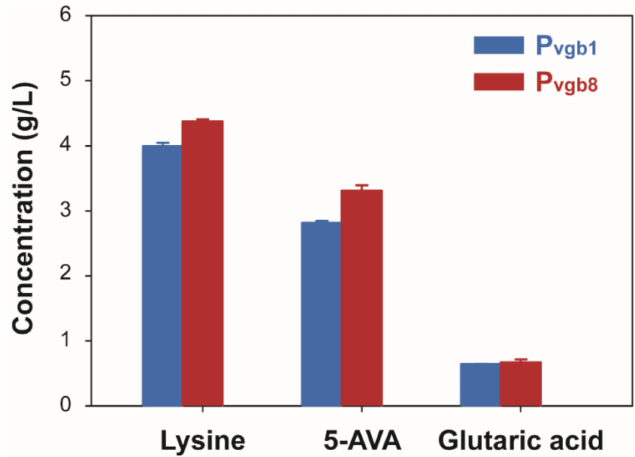
Figure 4. 5-Aminovaleric acid, L-lysine, and glutaric acid production by recombinant C. glutamicum 5AVA1 His and 5AVA8 His strains under high aeration conditions after 120 h flask